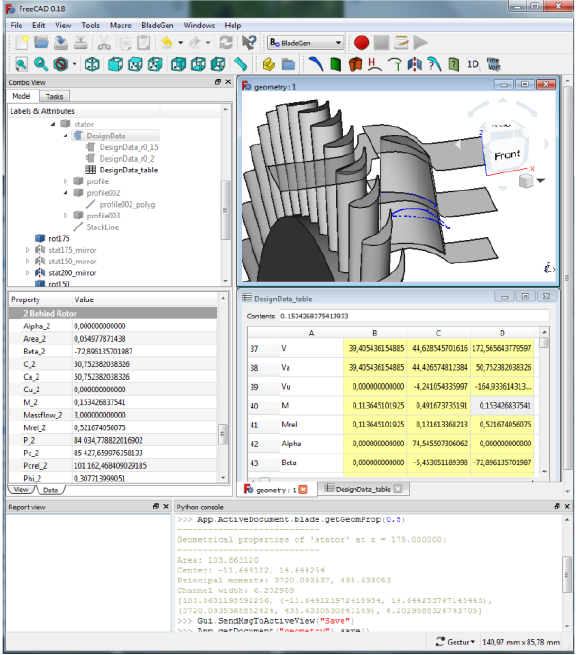
Fig. 5. Geometry of blades with 1D analysis of the stage.